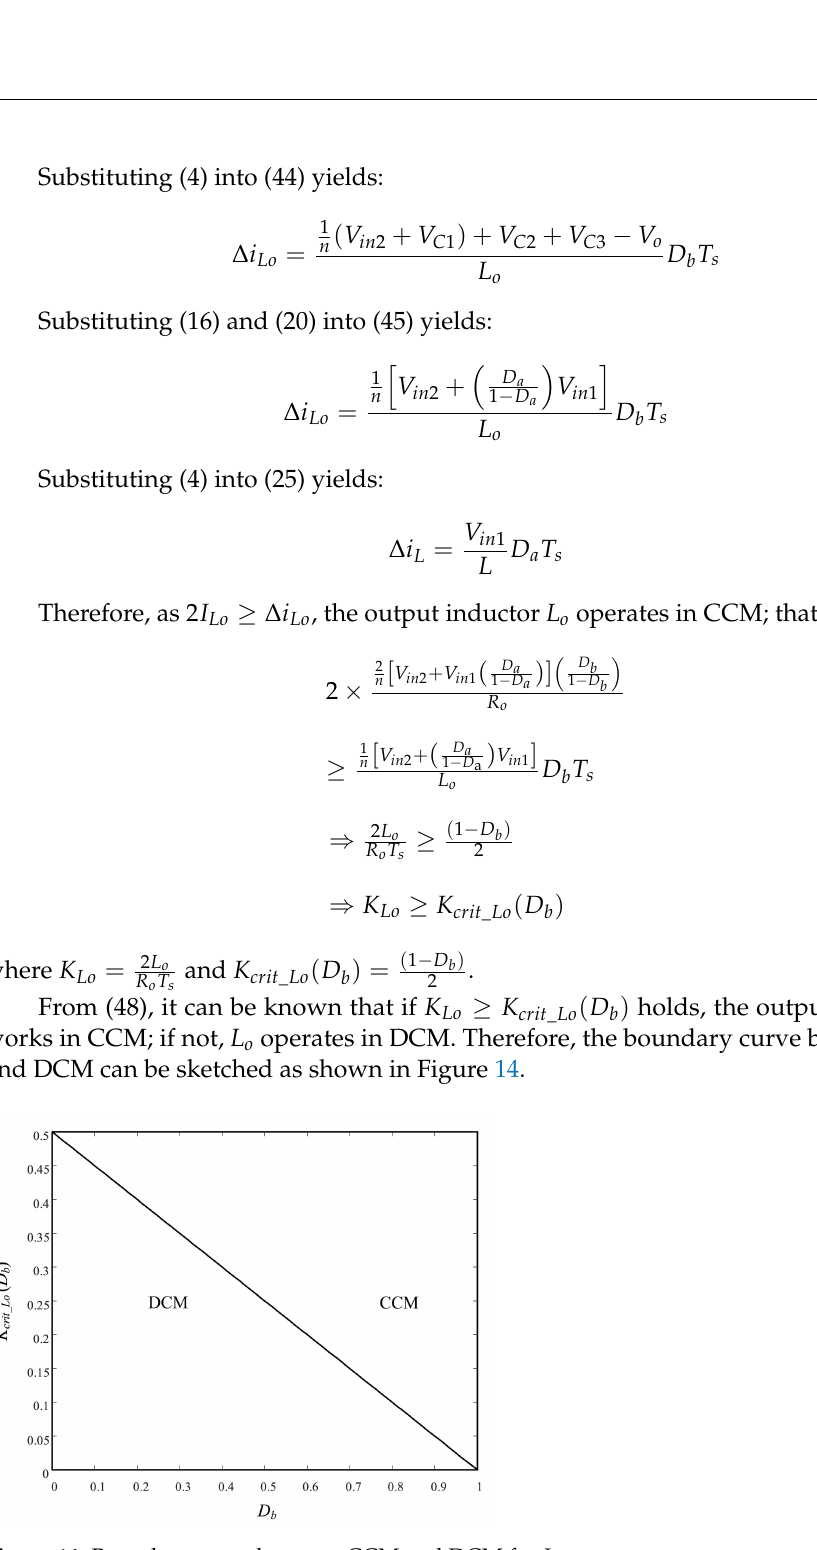
Figure 14. Boundary curve between CCM and DCM for L o